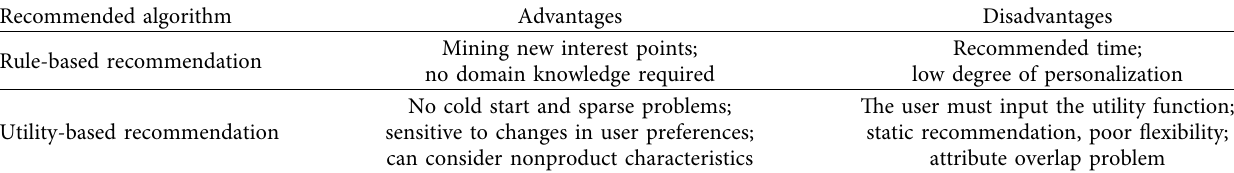
Table 3: Analysis of the advantages and disadvantages of each algorithm.